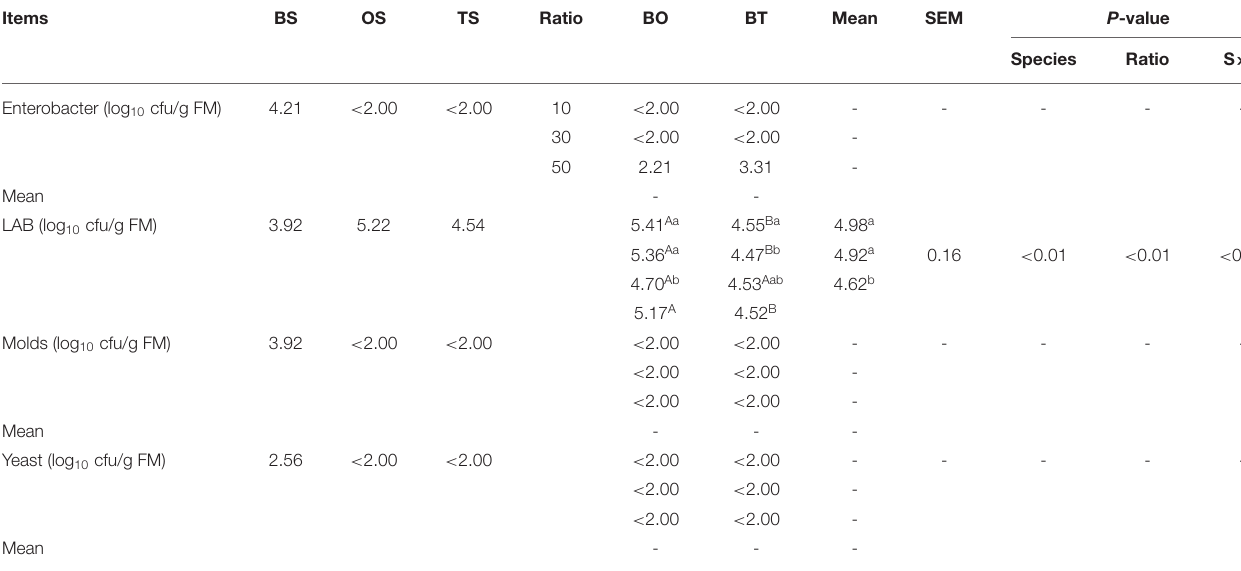
Species Ratio S × R